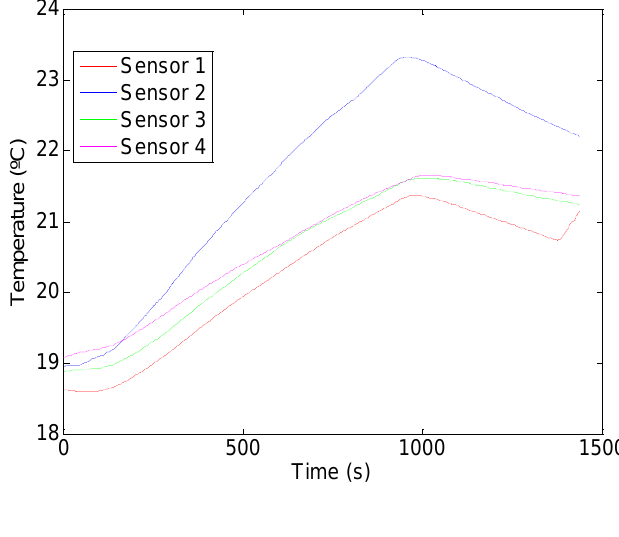
Figure 11. Temperature profile distribution in the office after the ambient